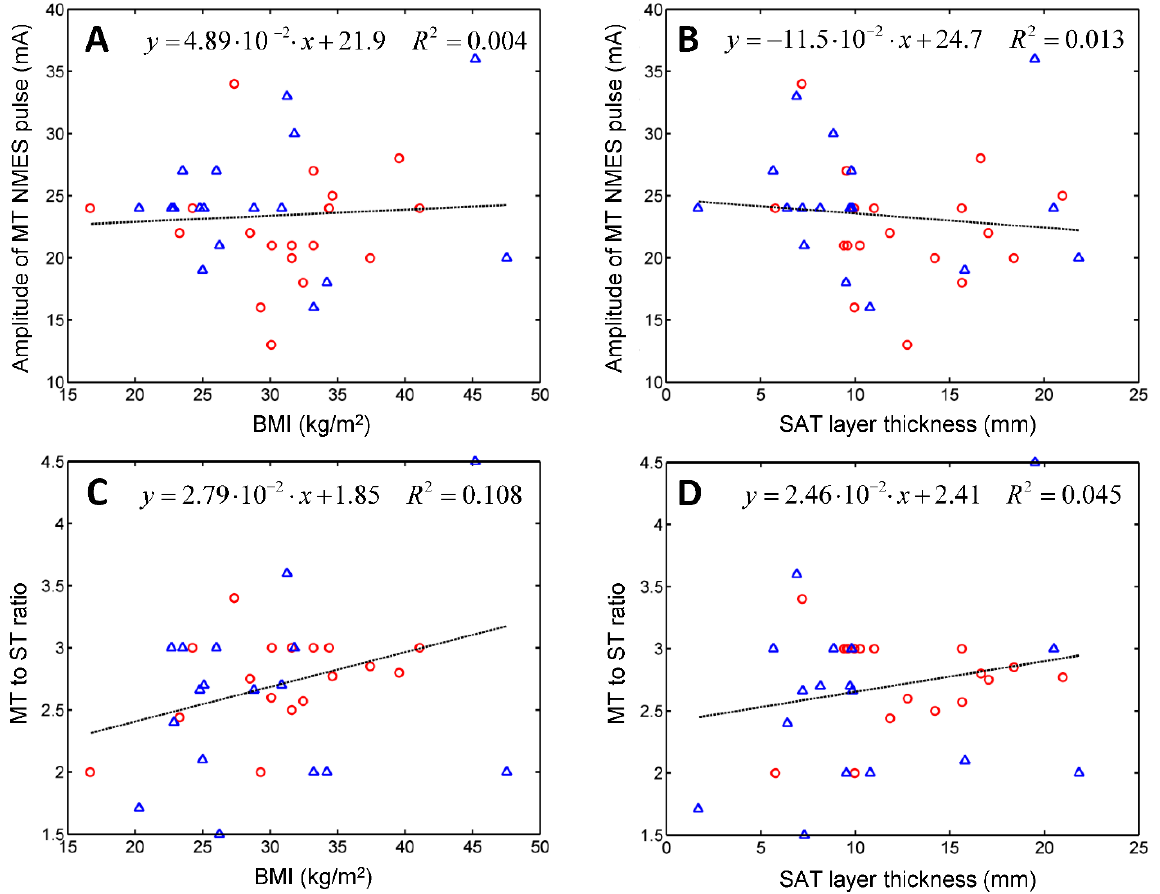
Figure 4. Scatter plots of the amplitude of the biphasic rectangular electric pulses of 0.35 ms duration needed to trigger the contraction of the quadriceps muscle vs. the BMI of the patient ( A ) and vs. the thickness of the subcutaneous adipose tissue (SAT) layer in the treated region ( B ), and the MT to ST ratio vs. BMI ( C ) and the SAT layer thickness ( D ). Circles and triangles represent data points of women and men, respectively.